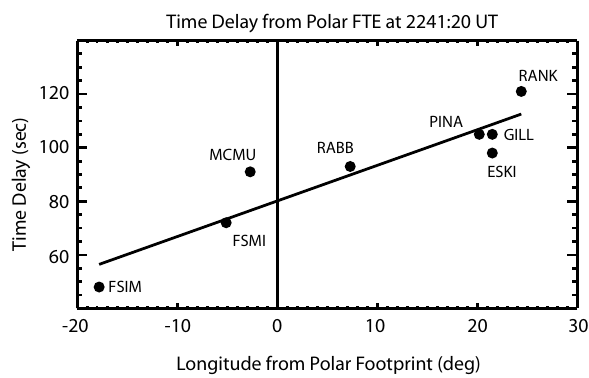
Fig. 15. Time delays of the FTE signature from Polar to the CANO- PUS stations as a function of the longitudinal distance from the Po- lar